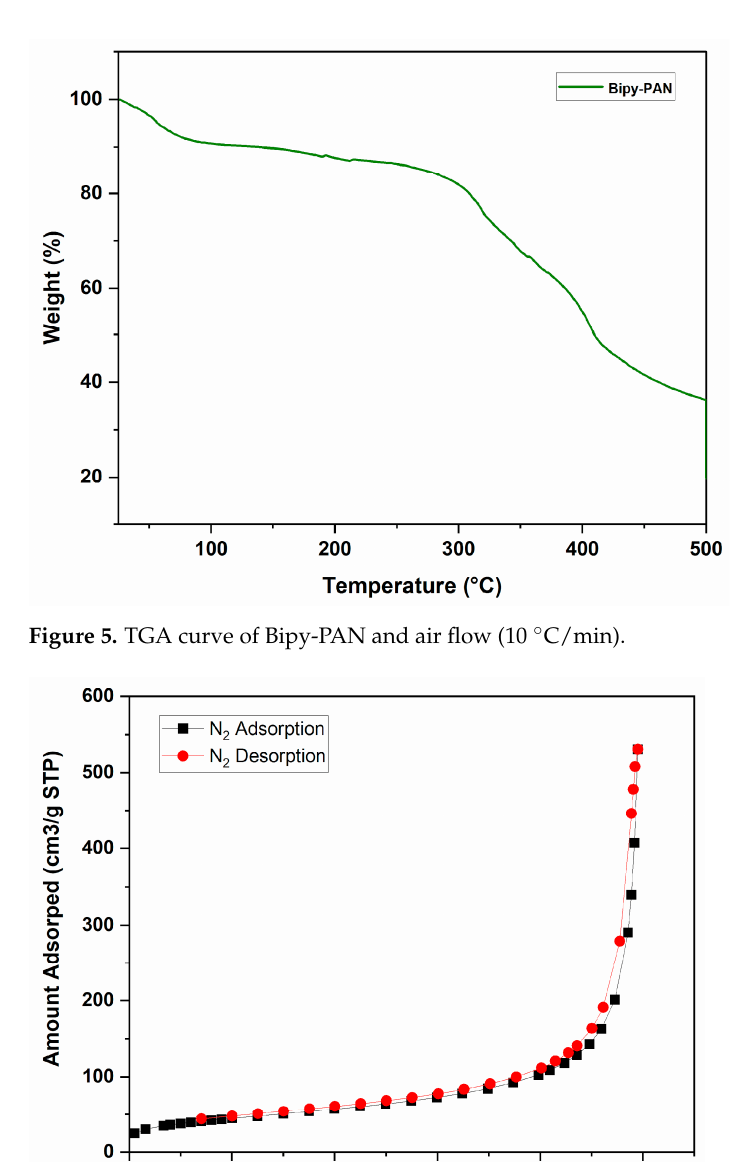
Figure 5. TGA curve of Bipy-PAN and air flow (10 °C/min).